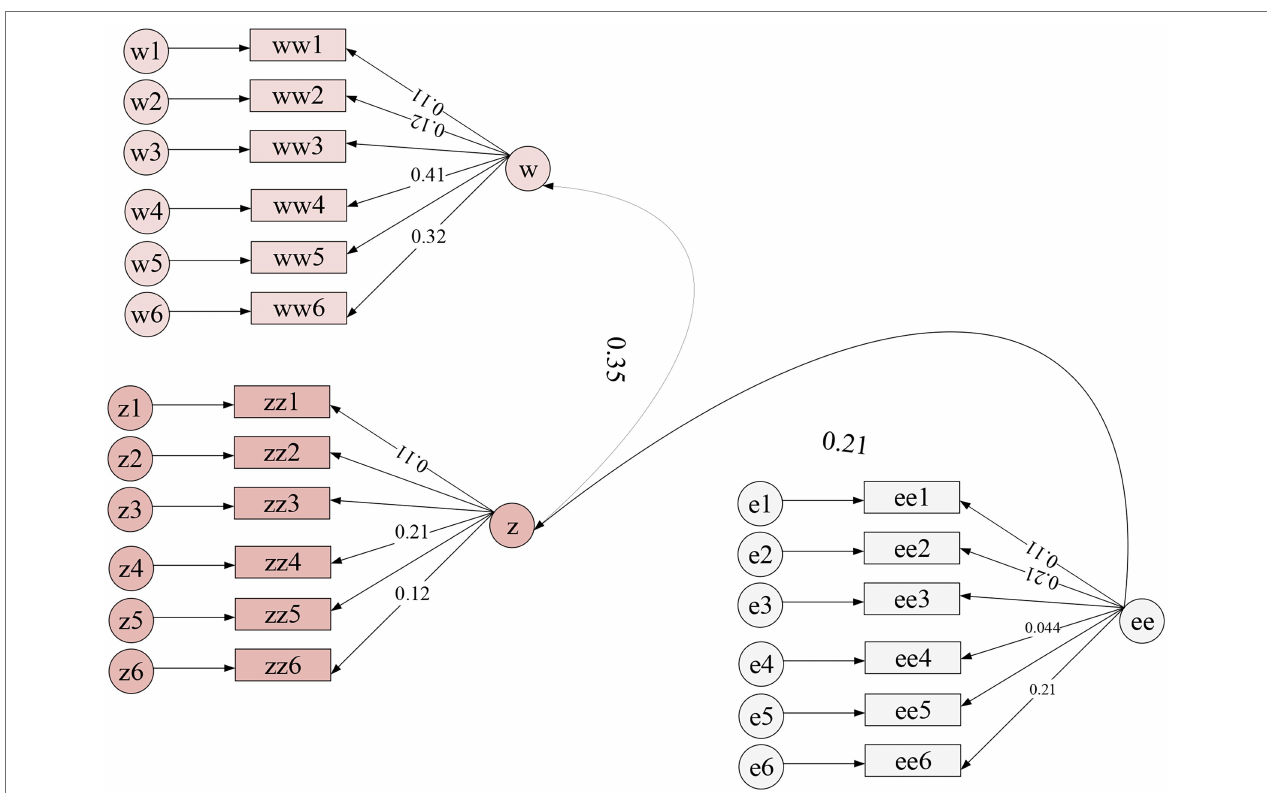
FIGURE 4 | Output result of Amos(2).